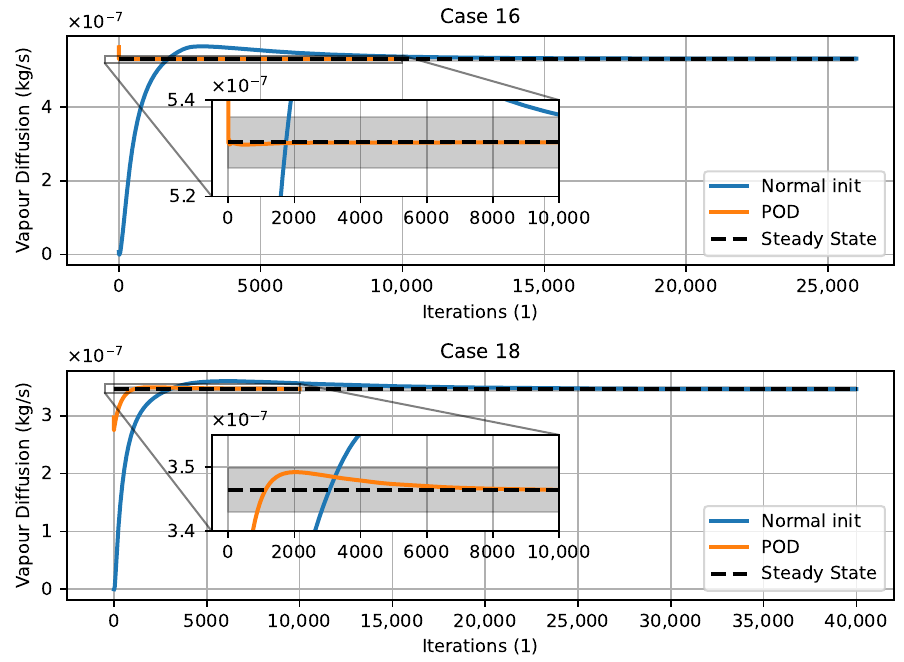
Figure 11. Convergence of the total water transfer rate for validation points 16 and 18. Blue curves: initialisation with uniform field values. Orange curves: initialisation with POD+I surrogate model